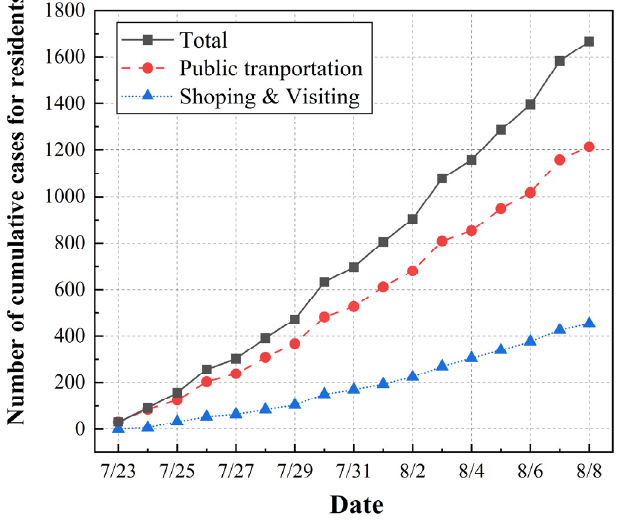
Figure 6. The predicted cumulative number of positive cases for residents infected by Olympic- related